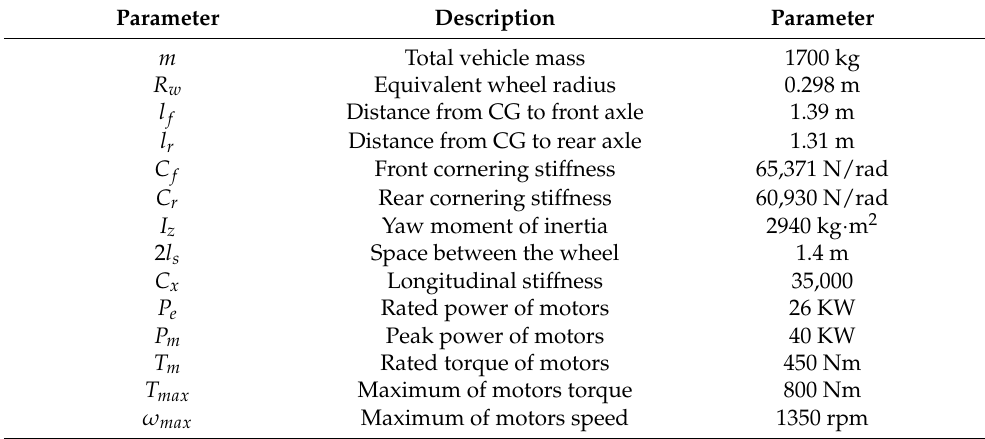
Table 1. Vehicle parameters used in the